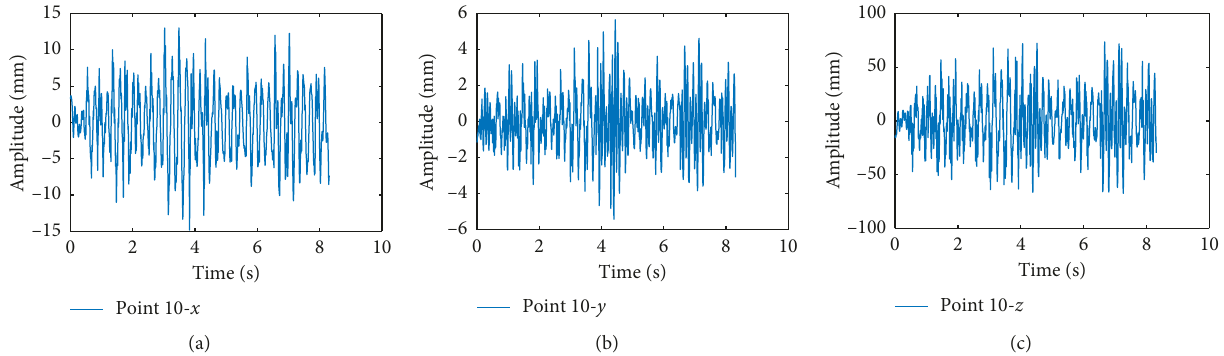
Figure 5: Vibration displacement curves of point 10 under random excitation: (a) X direction, (b) Y direction, and (c) Z